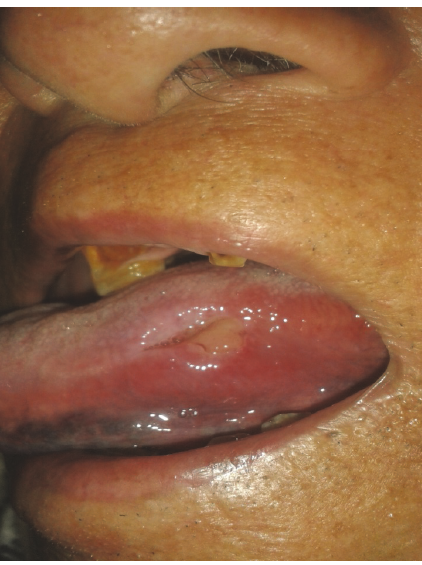
Figure 1: Ulcerated lesion of left lateral border of tongue (photo- graph was taken after incisional biopsy).